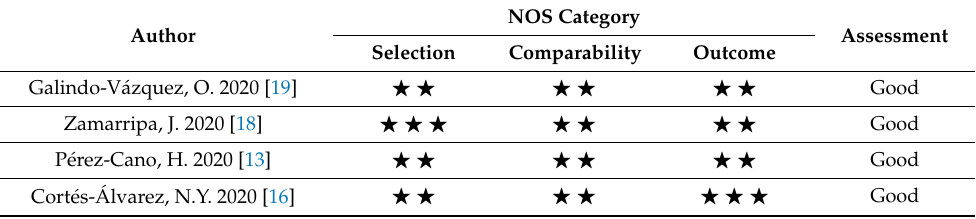
Table 2. Quality assessment of the studies included according to the modified Newcastle-Ottawa Scale (NOS). A total of nine stars can be awarded following certain criteria, with a maximum of four stars for the selection category, a maximum of two stars for the comparability category and a maximum of three stars for the outcome